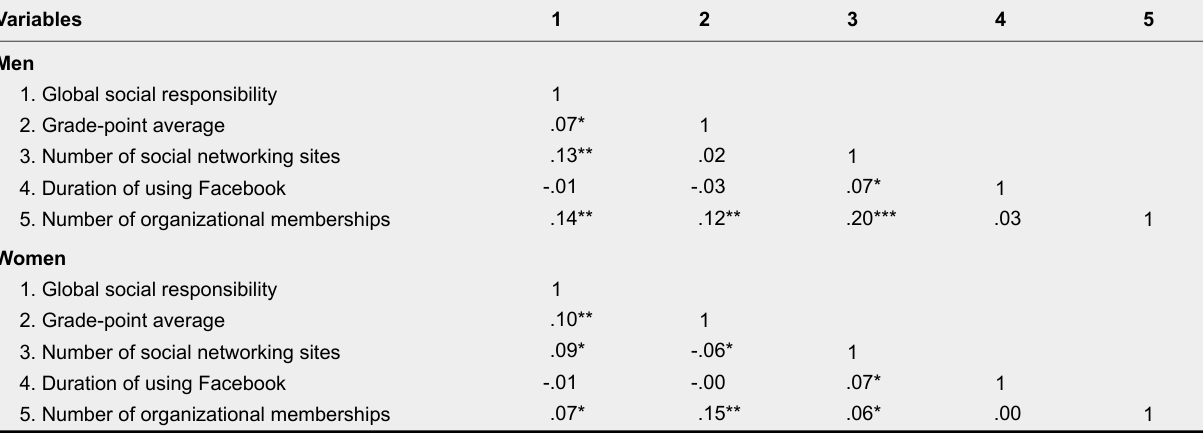
Correlations Between Global Social Responsibility and Assessed Variables by Gender